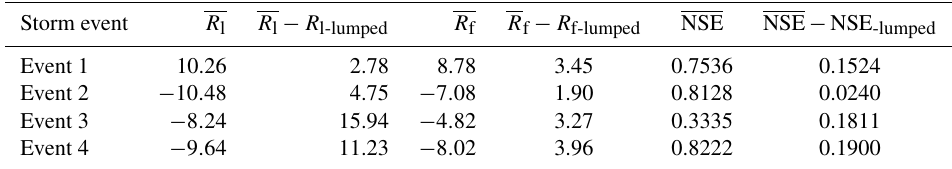
Table 9. Comparison between gridded system and lumped system for flood simulation results.